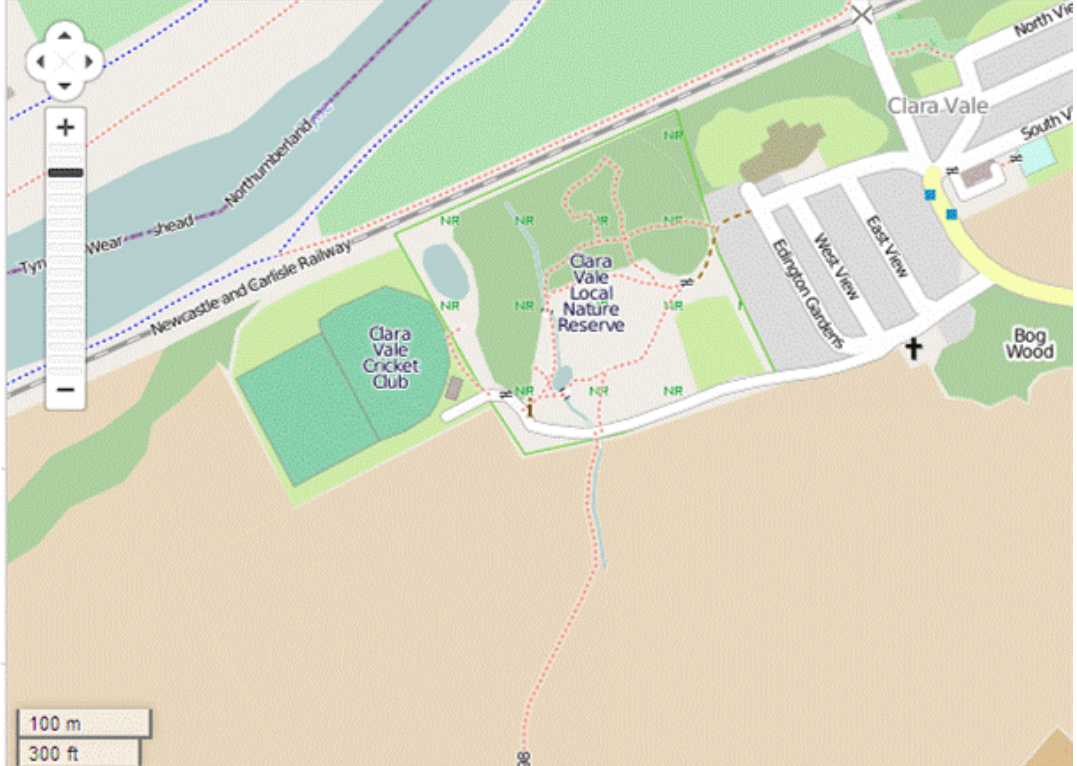
Figure 2. OpenStreetMap representation of the study area at Clara